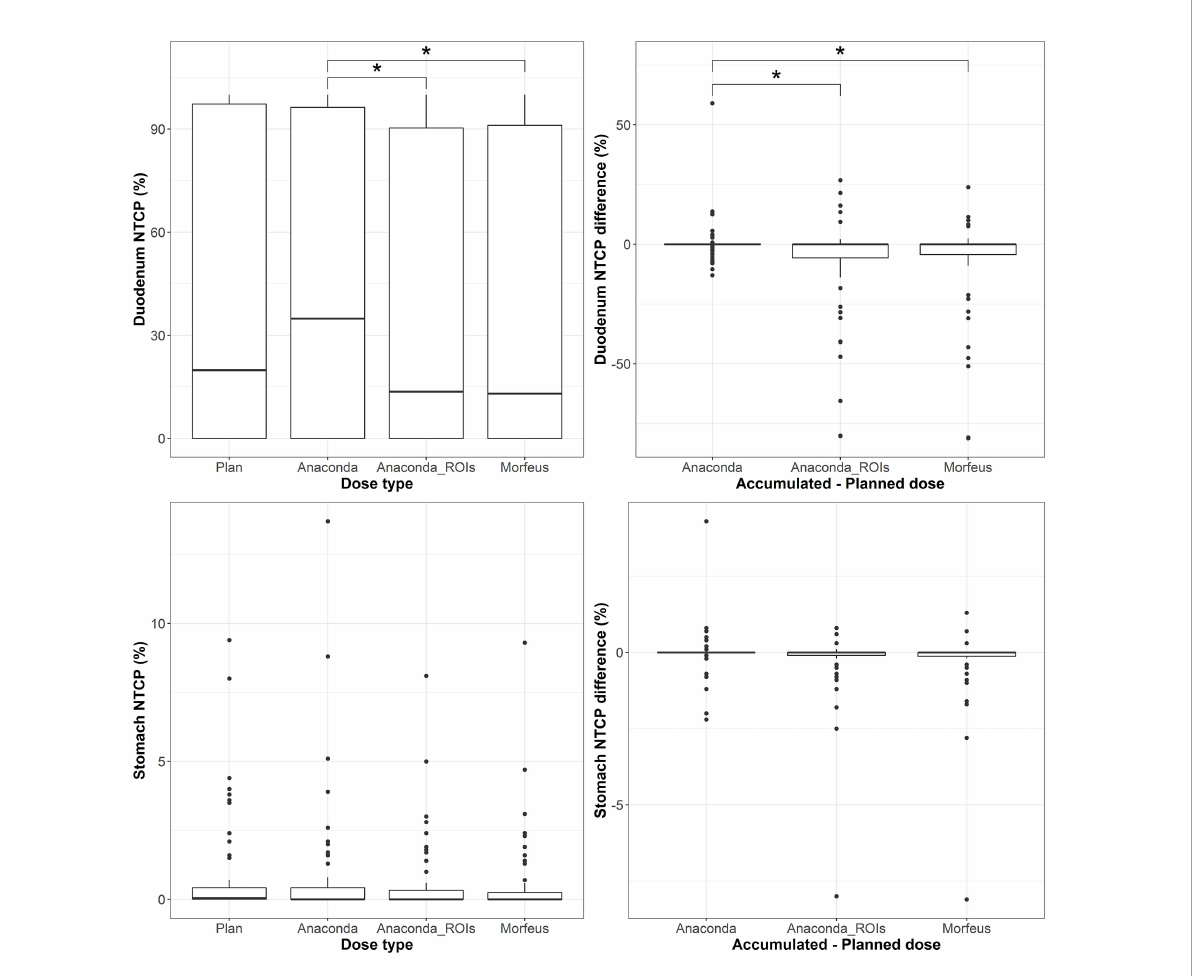
FIGURE 6 Top row: duodenum; Bottom row: stomach; Left: NTCPs; Right: NTCP differences between accumulated and planned dose. Statistically signi fi cant differences between means are indicated according to Bonferroni-adjusted p-values (*p